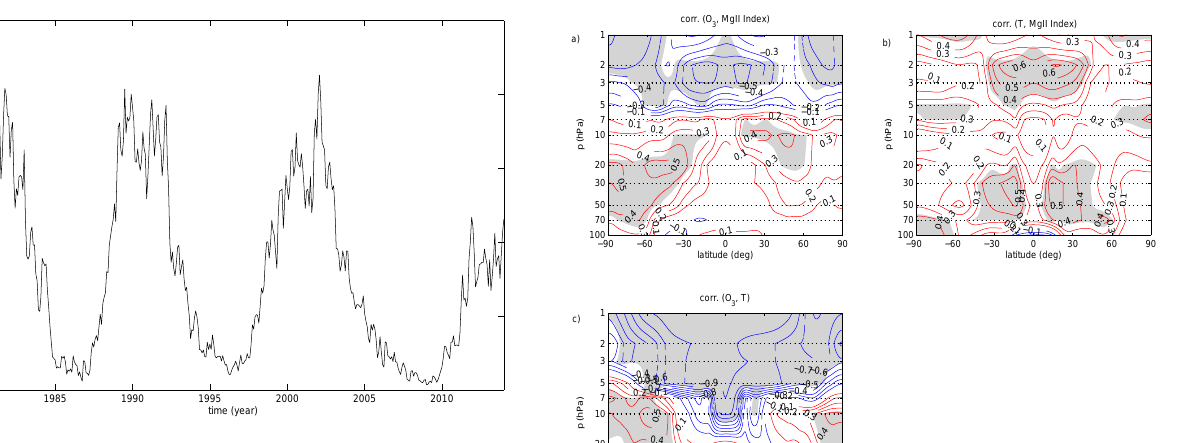
Figure 5. Monthly Mg II index time series from January 1979 to December 2013.